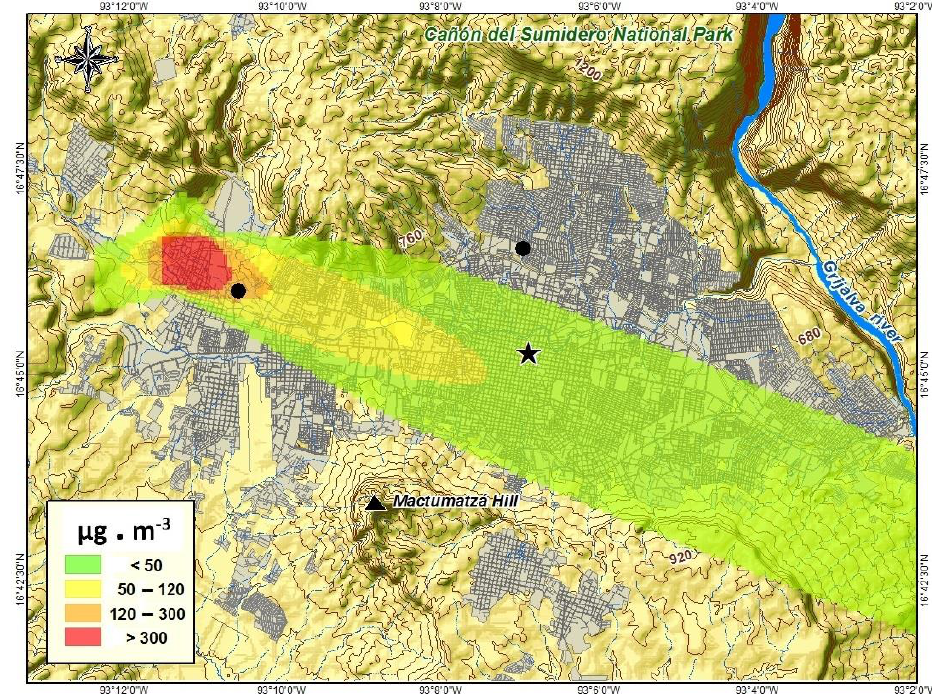
Figure 7. Dispersion of PM 10 dust particles over TGZ as simulated by the ISC3 model. Plume originating from Plan de Ayala during March 8th, 2014. Points for Minivol monitoring PM 10 concentration are represented by ● . The central part of the city is represented by . The blue lines represent the presence of rivers and streams. The brown slight lines represent elevation in meters above sea level.